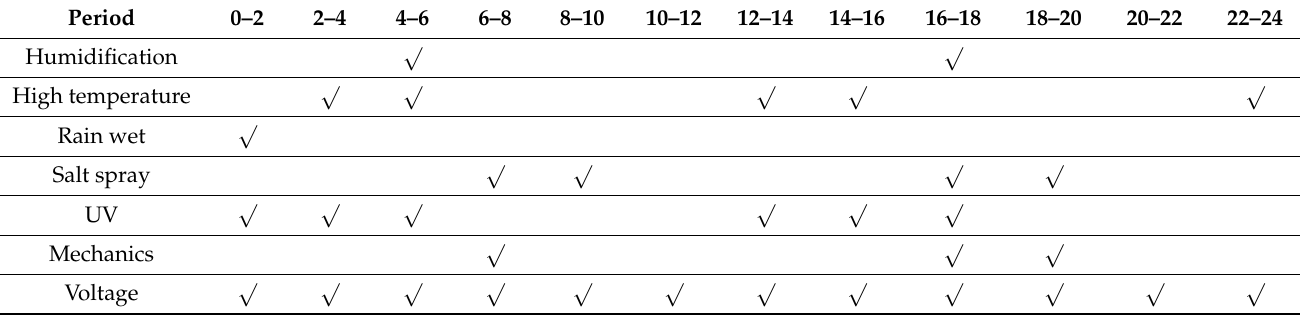
Table 2. Composite cross arm 5000-h multi-factor aging test cycle